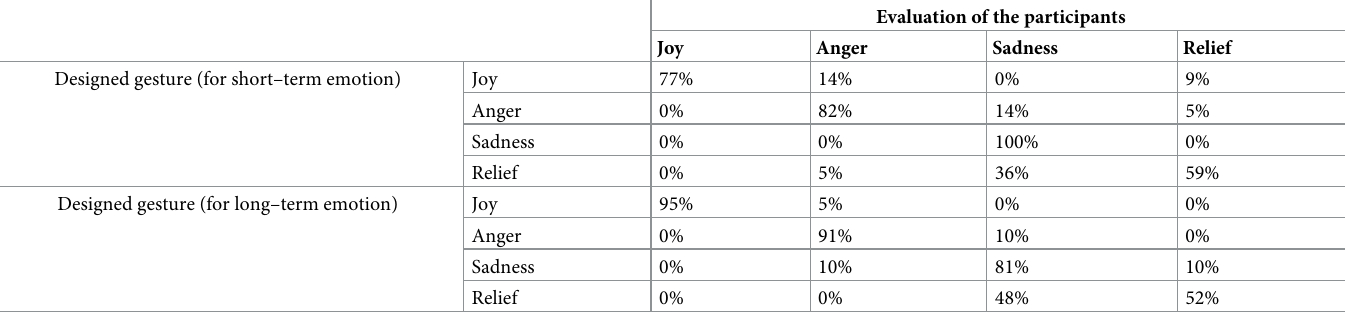
Table 1. Result of the gesture contest.